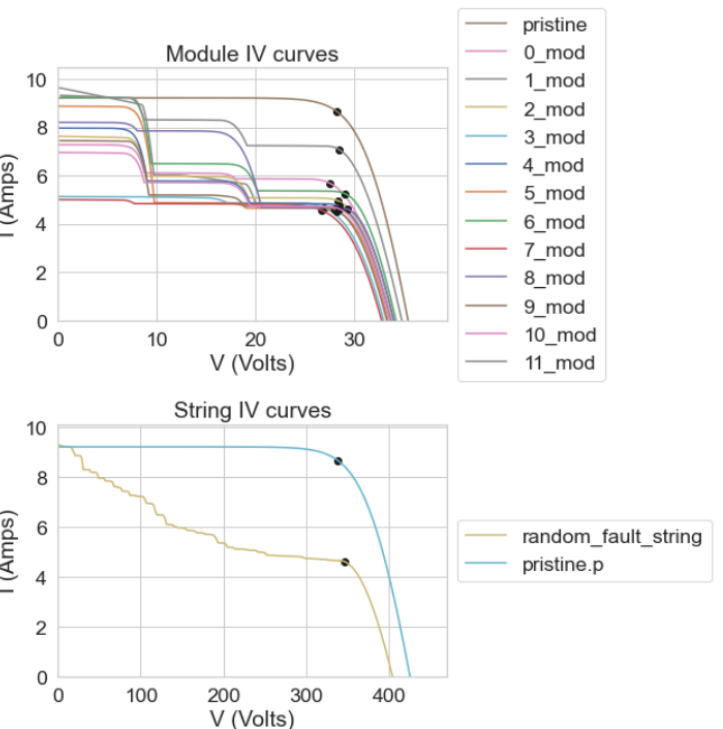
Figure 6. Module-level and string-level IV curves display a random failure, capturing the flexibility of the simulation